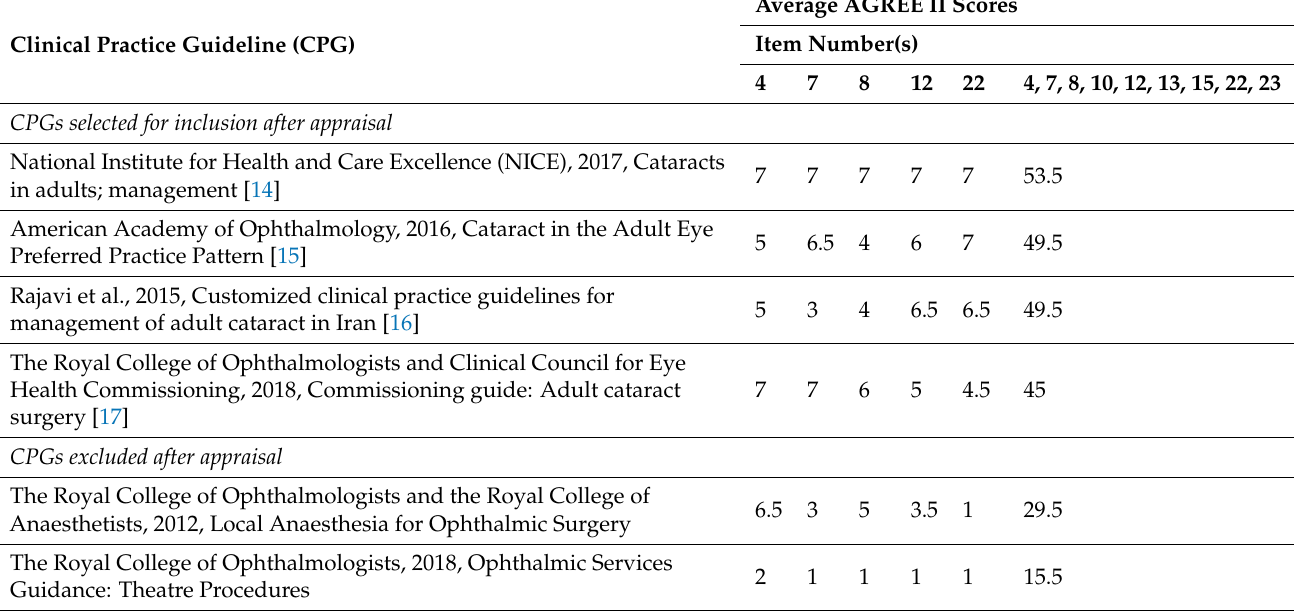
Table 3. AGREE II scores for the Clinical Practice Guidelines (CPGs) that were selected for appraisal after full text